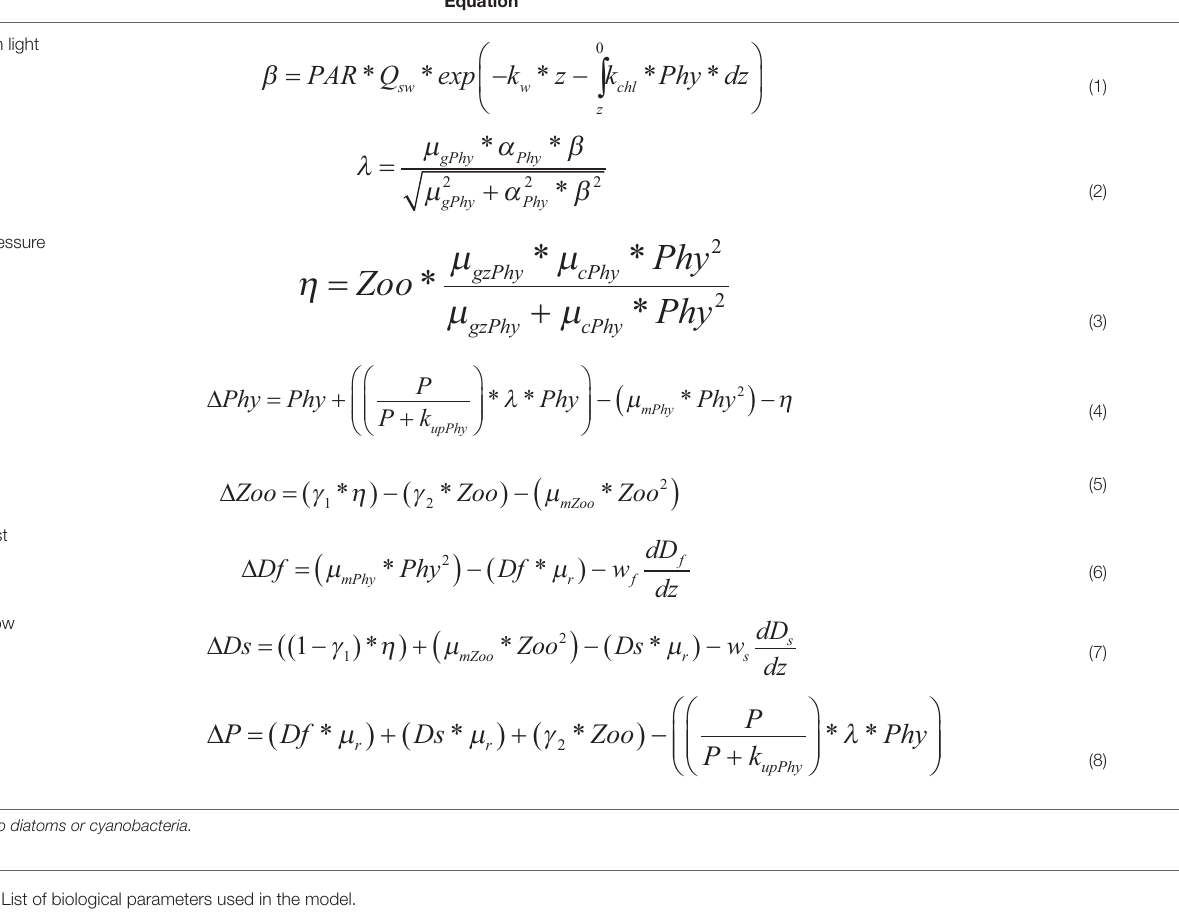
TABLE 1 | Equations of the biological model. Variable Equation Attenuation light